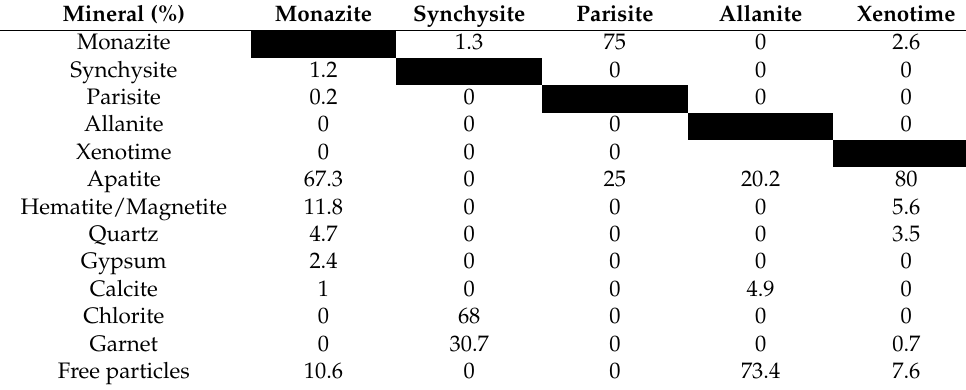
Table 5. Mineral associations of REE minerals in flotation concentrates as revealed by TIMA (Chitosan was used as a depressant at 150